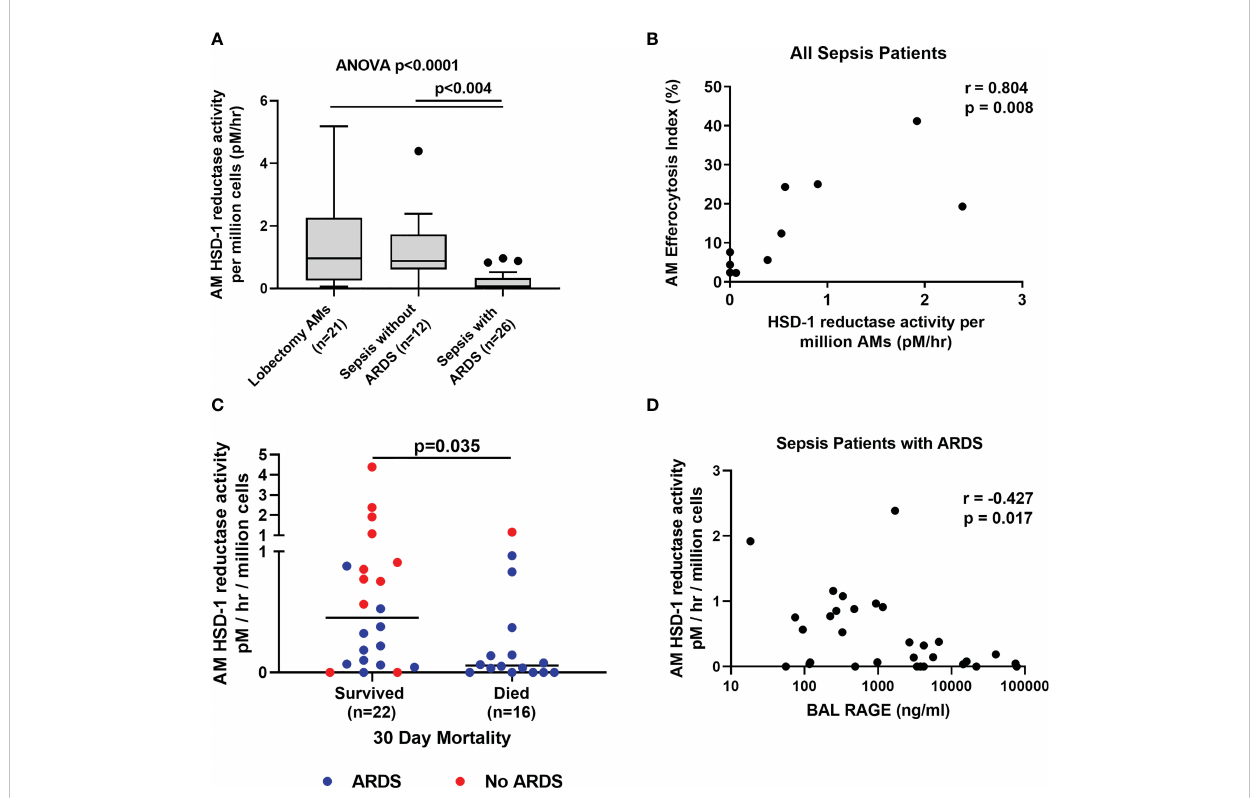
FIGURE 2 Alveolar macrophage HSD-1 reductase activity compared between patient groups. (A) AM HSD-1 reductase activity in lobectomy patients, sepsis patients without ARDS and sepsis patients with ARDS (medians 0.967 v 0.882 v 0.075 pM/hr/10 6 AMs, Kruskal-Wallis p<0.0001, Dunn ’ s post-hoc p<0.004). Data shown as Tukey ’ s box plots. (B) Correlation between AM HSD-1 reductase activity and alveolar macrophage efferocytosis index, across all sepsis patients with and without ARDS (r= 0.804, p=0.008, n=10). (C) Association between AM HSD-1 reductase activity and 30